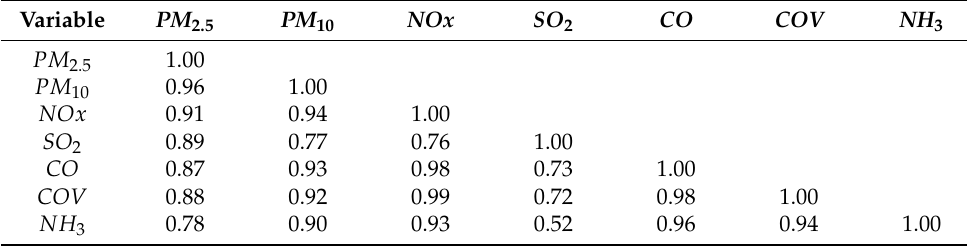
Table 3. Emissions correlation matrix.